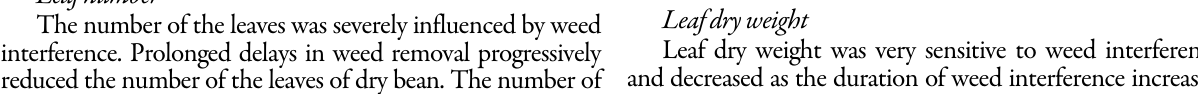
Table 2. Boltzmann equations for leaf number, leaf dry weight, internode length and harvest index of dry bean in weedy and weed-free plots depending on the days after emergence (X) Crop